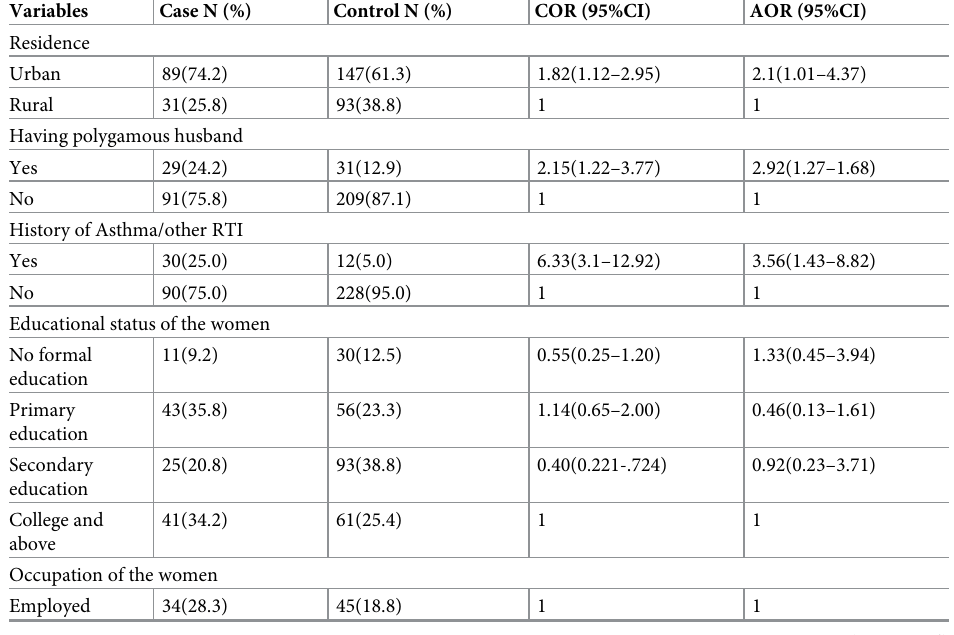
Table 4. Multivariable logistics regressions results for determinants of HEG among pregnant women attending health care service in public hospitals, southern Ethiopia,